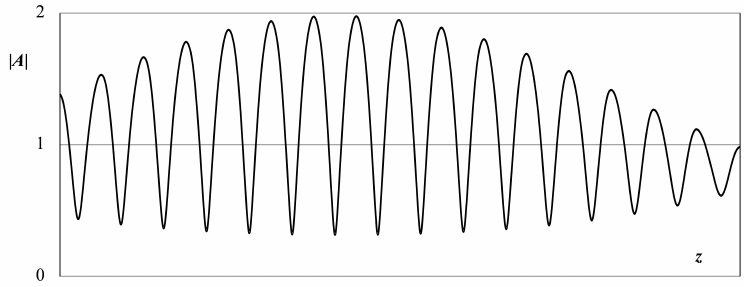
Figure 5. Amplitude of the electric component of electromagnetic field in a periodic structure obtained using the Cantor method and a period increased by 10% at λ = 680